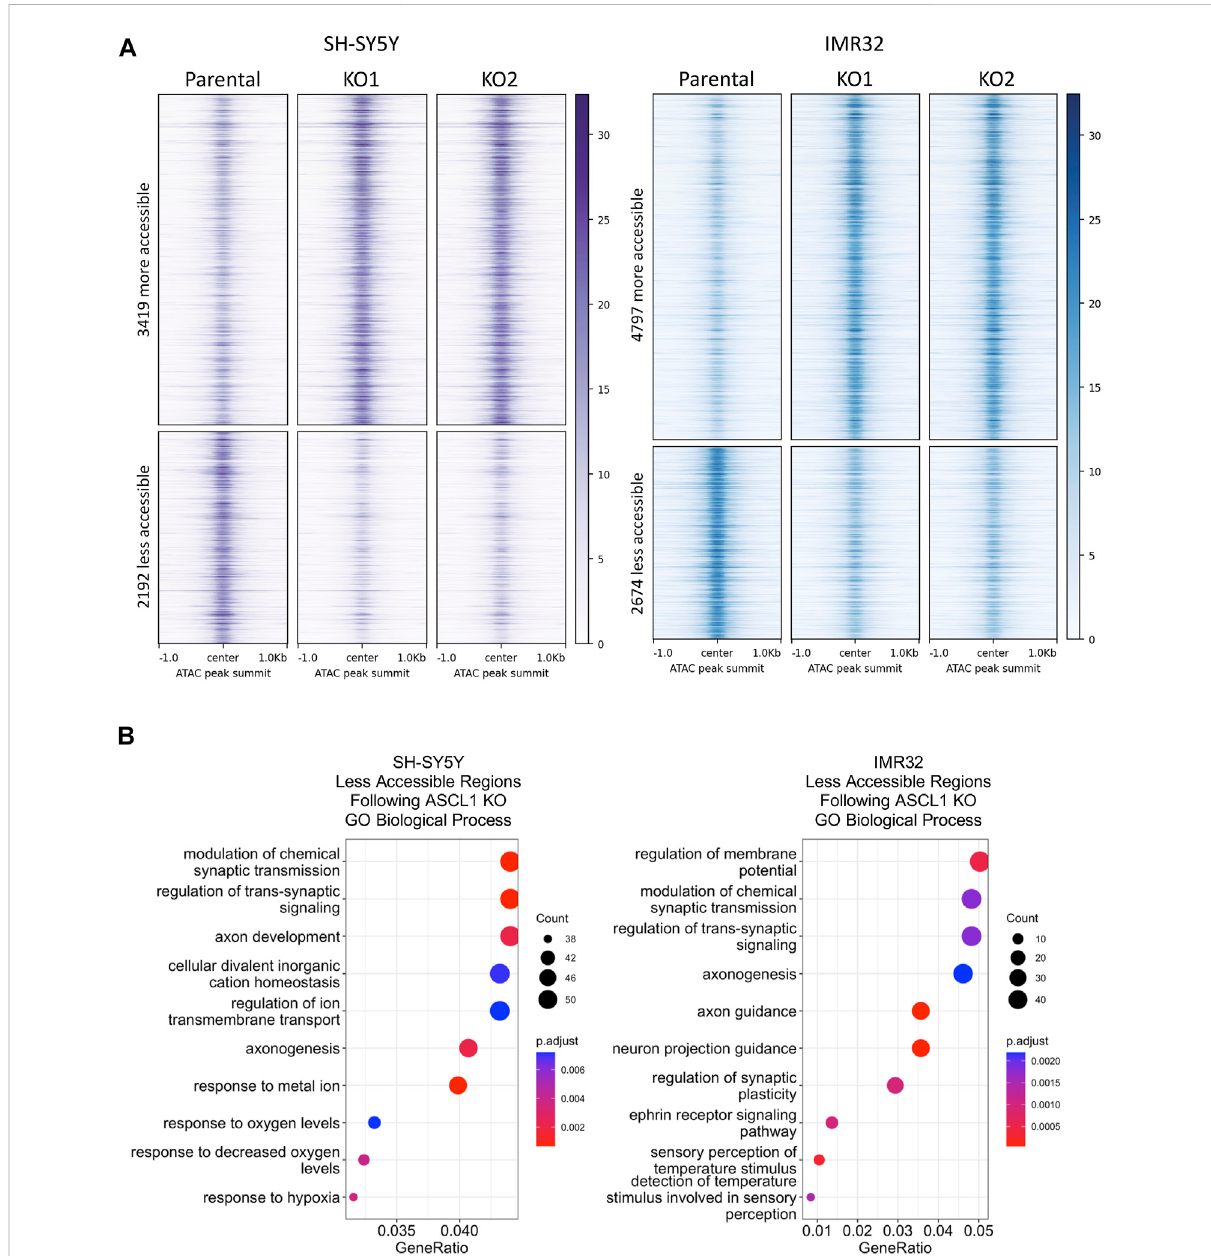
FIGURE 3 Differentiation targets are less accessible in ASCL1 KO lines. (A) Signal intensity − /+1kb around peak summits of all regions with signi fi cantly altered accessibility in ASCL1 KO cell lines, for SH-SY5Y cells (purple) and IMR32 cells (blue). ATAC-seq data is RPGC normalised and the average of four replicates. (B) Genes were identi fi ed that were within 50 kb of an ATAC region with lower accessibility following ASCL1 KO. Gene Ontology analysis was performed on these gene sets, SH-SY5Y (left) and IMR32 (right). The top 10 GO terms are shown. ATAC-Seq completed on 4 biological